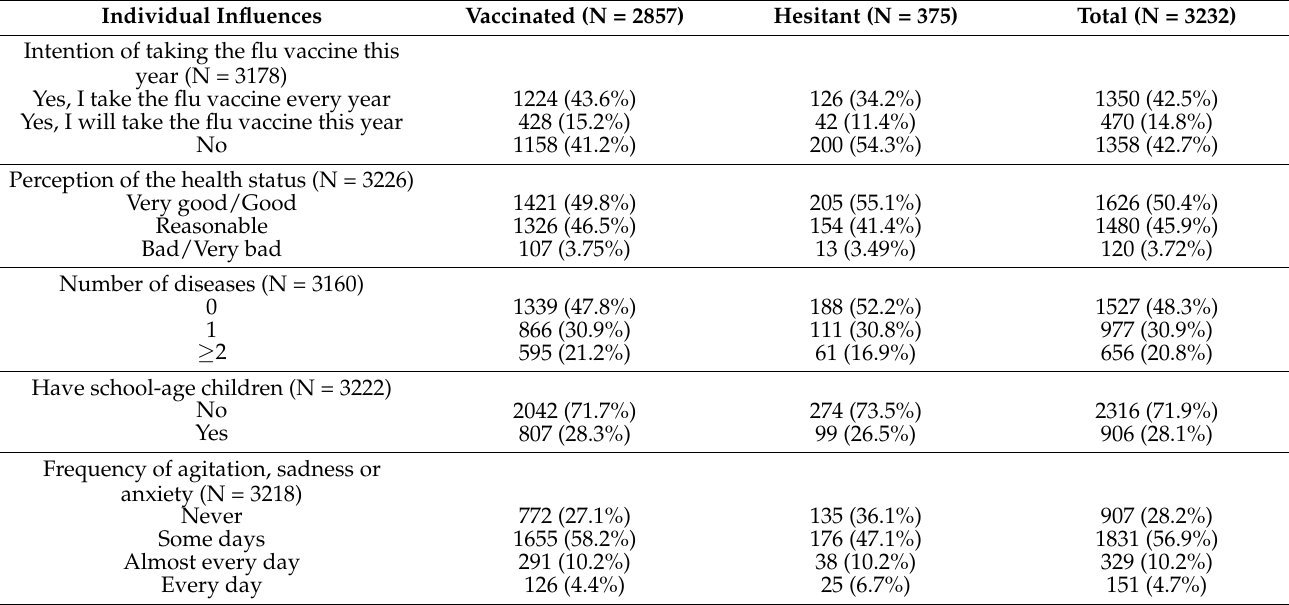
Table 3. Sample characteristics according to individual